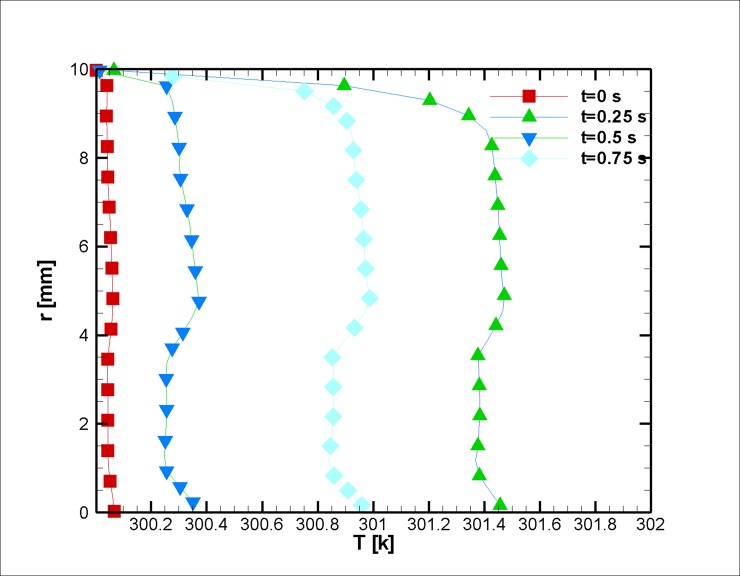
Temperature distribution at z = 4 cm for the case of Joule heating at various simulation instances, Lvessel = 7 cm, Rvessel = 1 cm and fifty percent stenosis.